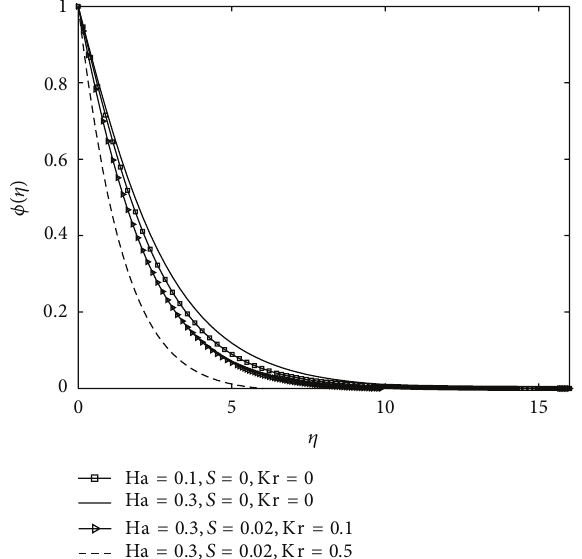
Figure 14: Concentration profiles for different values of Ha, 𝑆 , and Kr for Gr = 0.1 , Gc = 0.1 , Sc = 0.62 , Bi = 0.1 , Nc = 0.01 , and Pr = 0.72 .